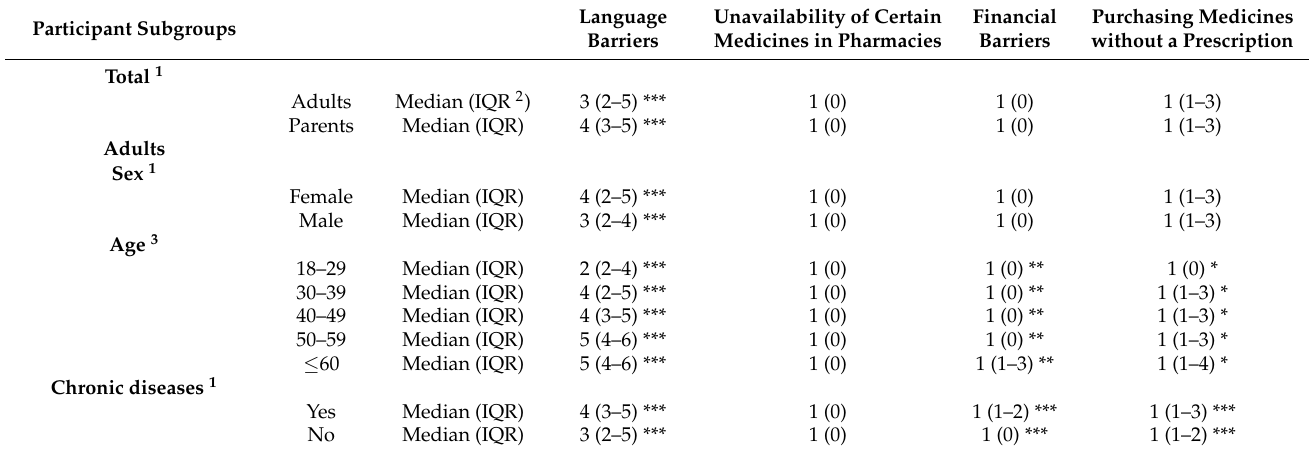
Table 2. Descriptive statistics for different participant groups according to four factors influencing access to medicines. Participant Subgroups